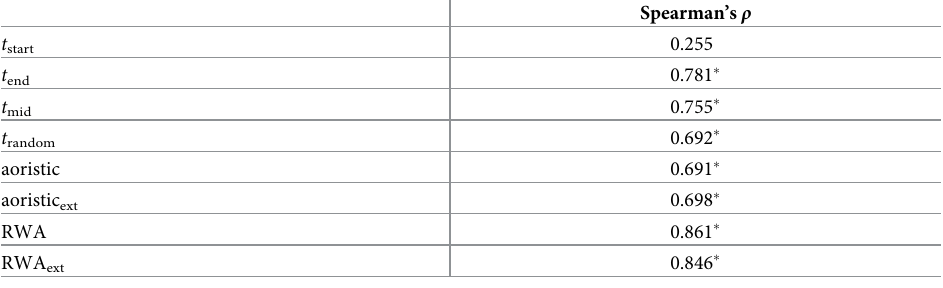
Table 2. Statistical results comparing eight approximated offense times with exactly measured offense